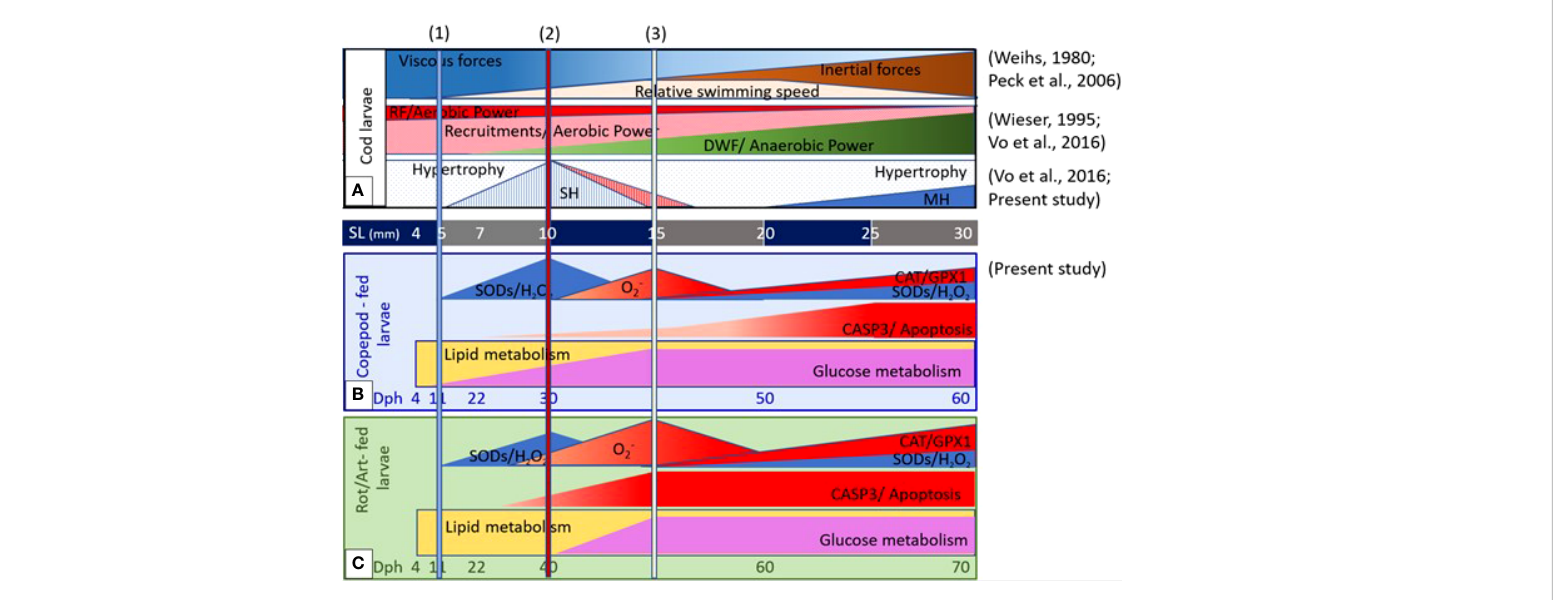
FIGURE 7 Proposed correlation between muscle development and growth dynamics, external and internal drivers, and energy metabolisms in relation to live prey types during ontogeny of cod larvae. (A) Changes in viscous and inertial forces and relative swimming speed (Weihs, 1980; Peck et al., 2006), and the relationship between aerobic and anaerobic power in different muscle fi ber types (Wieser, 1995), and muscle growth dynamics between hypertrophy and hyperplasia (Vo et al., 2016; the present study) develop as a function of body size. Live prey types affected the levels of ROS generation and regulation and the shift in metabolisms from lipid and glucose in (B) cod larvae fed copepods and in (C) cod larvae fed rotifers and Artemia (the present study). The columns at 5-, 10-, and 15 mm standard length (SL) indicate when cod larvae start a viscous swimming mode, the transitional swimming mode, and the inertial swimming mode (1, 2 and 3) (Weihs, 1980; and Peck et al.,